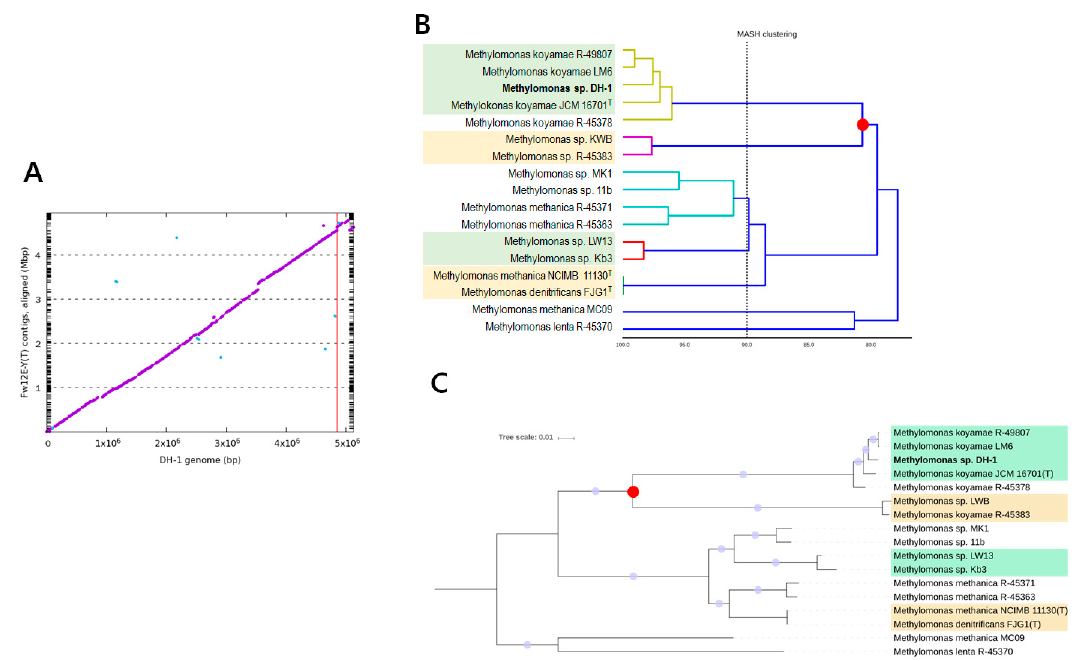
Figure 2. Comparative genomic and phylogenetic analyses of 17 Methylomonas strains. ( A ) Whole-genome alignment between DH-1 ( x -axis) and Fw12E-Y T ( y -axis). The red vertical line at the 4.85 Mb position represents the concatenation junction between the chromosome and the plasmid sequences. Ticks on the y -axis denote the ends of aligned contigs. ( B ) The average nucleotide identity (ANI) dendrogram based on genome sequence similarities. Strains in one colored box belong to one species. ( C ) Phylogeny of Methylomonas strains based on the concatenated 37 marker gene sequences, visualized using the Interactive Tree Of Life server (http://itol.embl.de/). Colored circles on branches represent local support values based on the Shimodaira–Hasegawa test (>0.998). Red circles indicate clades whose subtree topologies are congruent in both trees, which accommodate all strains with the original label M. koyamae .